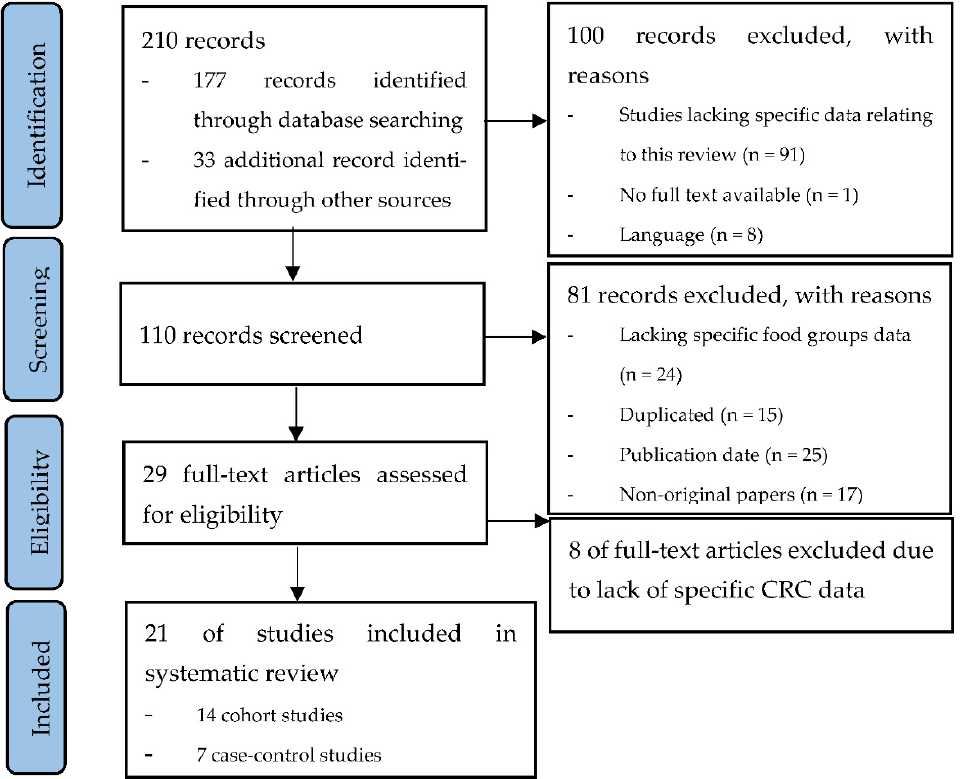
Figure 1. PRISMA flow diagram summarizing the identification and selection of the relevant publications about the associations between the consumption of dairy products, fish, white meat, and eggs and the risk of colorectal cancer.